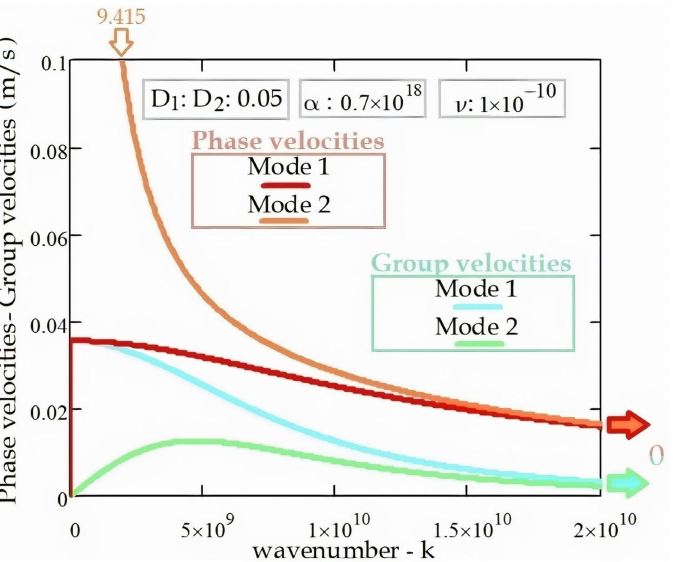
Figure 10. The phase and group velocities of the EM wave propagation in the